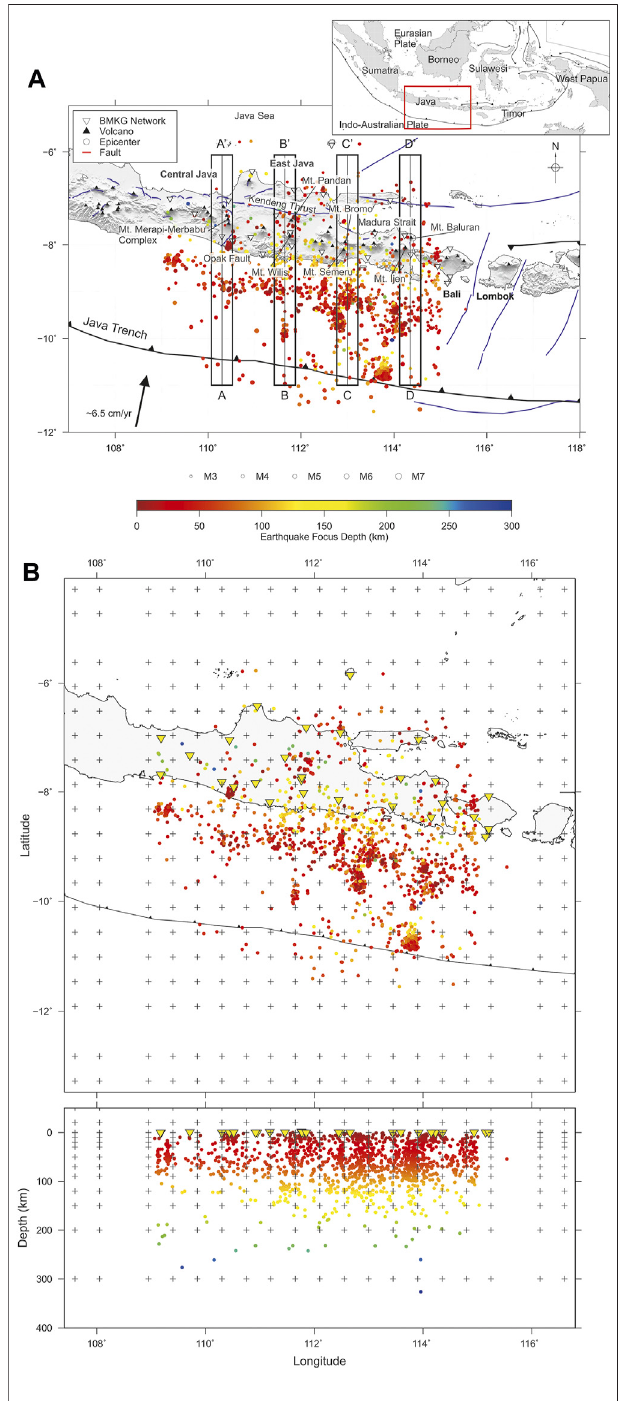
FIGURE 1 | (A) Map showing the distribution of 27 BMKG stations (inverted triangles) and seismicity used in this study from January 2009 to September 2017. The rectangles A-D are the area used to plot the vertical cross-section in Figure 3 and Figure 5 . (B) Grid node parameterization used for the seismic tomographic inversion (plus signs). The colors of the circles represent earthquake focus depth, active fault lineaments (blue lines) and volcanoes (black triangles) (Marliyani, 2016; Pusat Studi Gempa Nasional (PuSGeN),